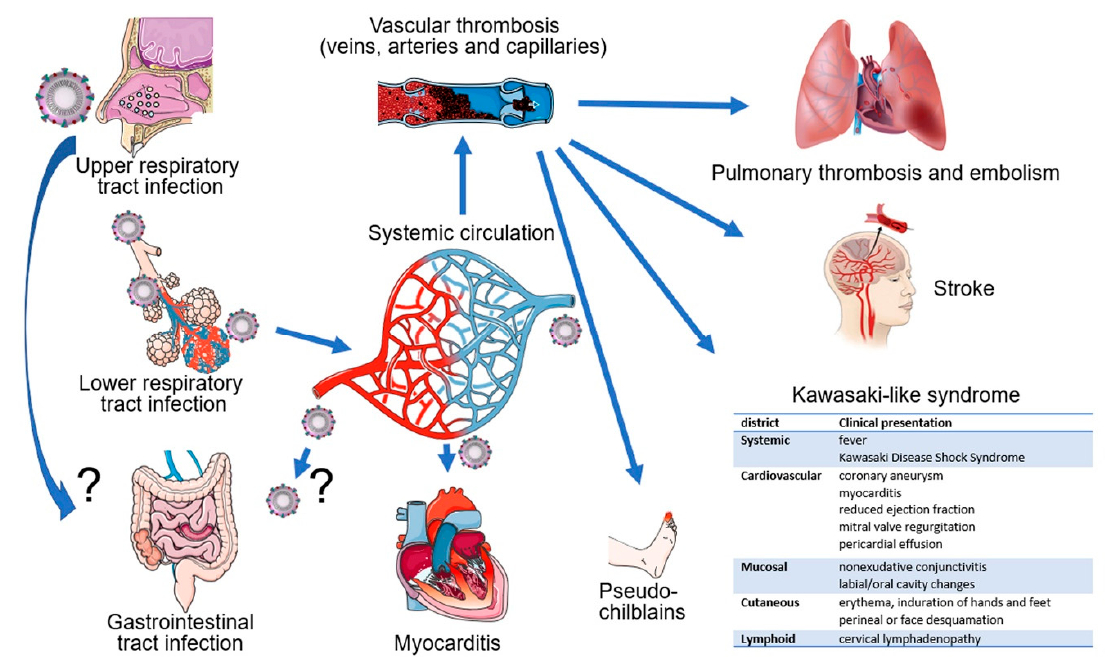
Figure 2. SARS-CoV-2 infects humans through the respiratory track by infecting and replicating in the epithelial cells that line the upper and lower respiratory track. In the lungs, the virus can cause COVID-19 pneumonia. SARS-CoV-2 can infect the intestinal epithelium in the small and large intestine; it is unclear whether this occurs through the oral route or dissemination from the respiratory track. SARS-CoV-2 can also infects myocardial cells. Hypercoagulation, vascular thrombosis and embolization are common in severe COVID-19 leading to pulmonary, brain and skin embolization. Kawasaki-like disease is linked epidemiologically to COVID-19.